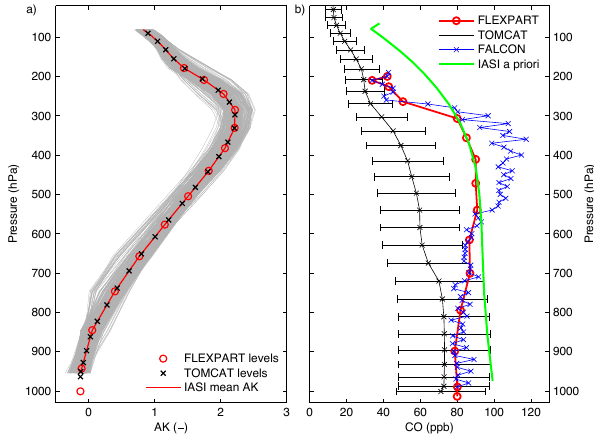
Fig. 1. (a) Background CO profiles from the FALCON GRACE campaign data (blue line), background profile added to the FLEX- PART data (red), background CO of the TOMCAT simulations (black), and the a priori for IASI CO retrievals (green). See text for details. (b) Individual averaging kernels (gray) and mean (red) for IASI total column CO retrievals north of 60 ◦ N (black). FLEX- PART and TOMCAT data were weighted with the mean kernel in- terpolated to the FLEXPART altitude points (red